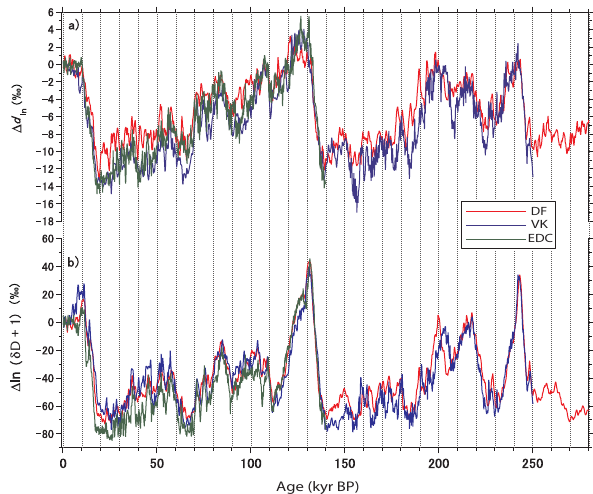
Fig. A3. Logarithmic defined deuterium-excess and δ D records of Antarctic ice cores. (a) Deuterium-excess based on logarithmic ex- pression ( d ln ) records from DF (red line), Vostok (blue line), and EDC (green line) cores plotted on the O 2 /N 2 orbital age scale for DF. (b) ln ( δ D+1) records of the three cores plotted on the O 2 /N 2 orbital age scale for